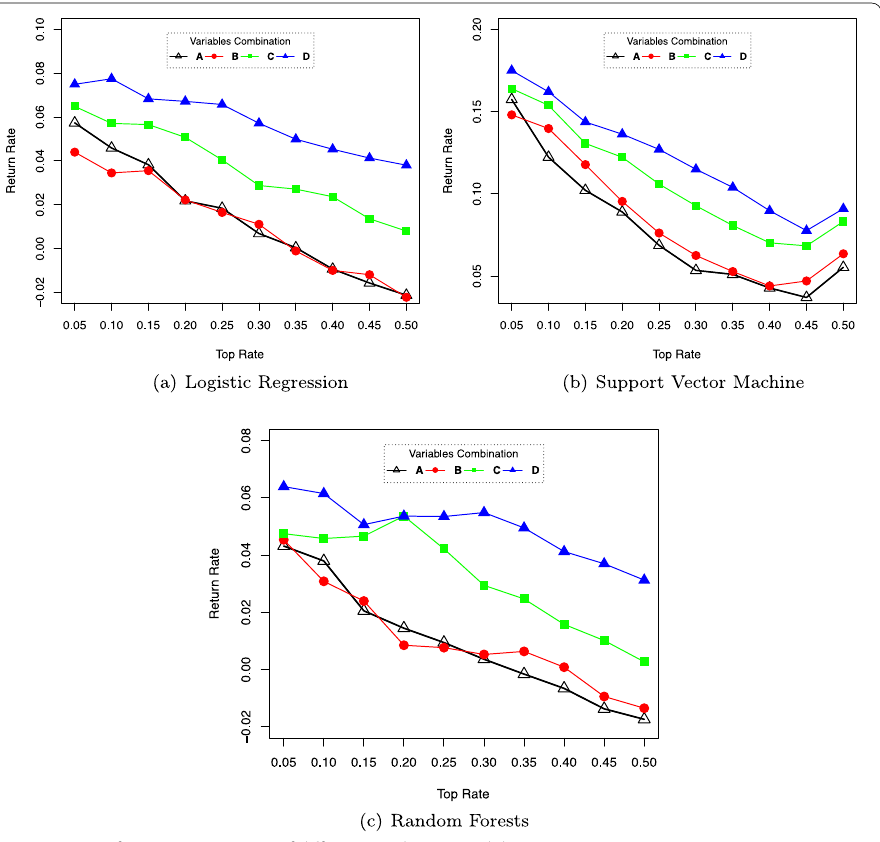
Fig. 11 Rate of return comparison of different predictive